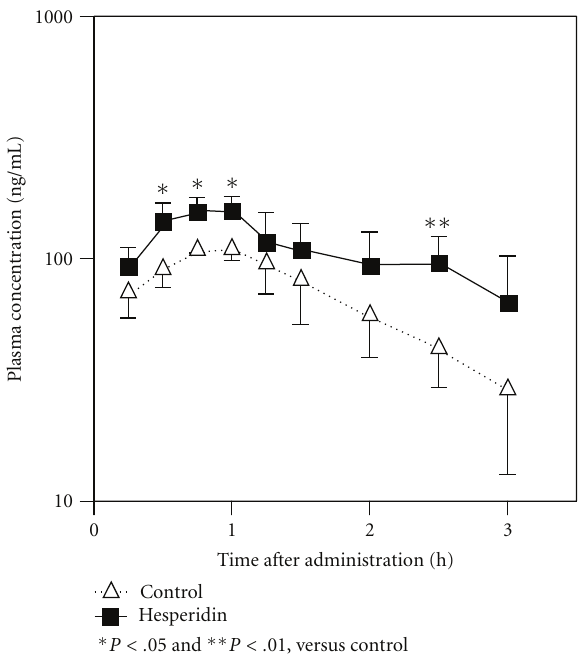
Figure 4: E ff ect of hesperidin (Hes) on the plasma concentration of pravastatin (PRV) in Sprague-Dawley rats. A hesperidin suspension was prepared at a concentration of 79 mg per 100mL of tap water (0.079%). The suspension instead of OJ was given according to the same schedule and volume as in the OJ study (Figure